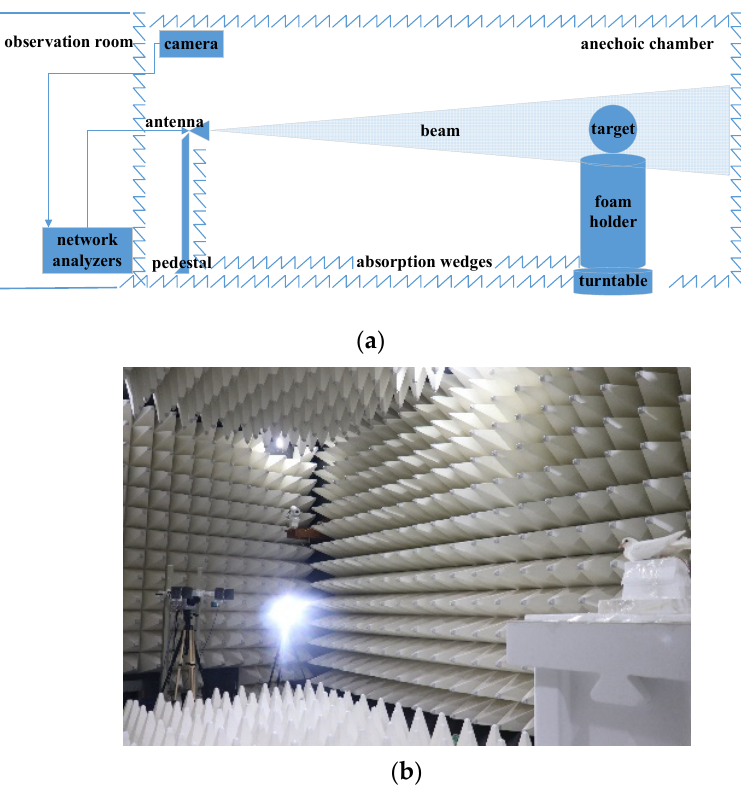
Figure 1. Environment of the anechoic chamber: ( a ) the spatial arrangement during the test, ( b ) a photo of the test.